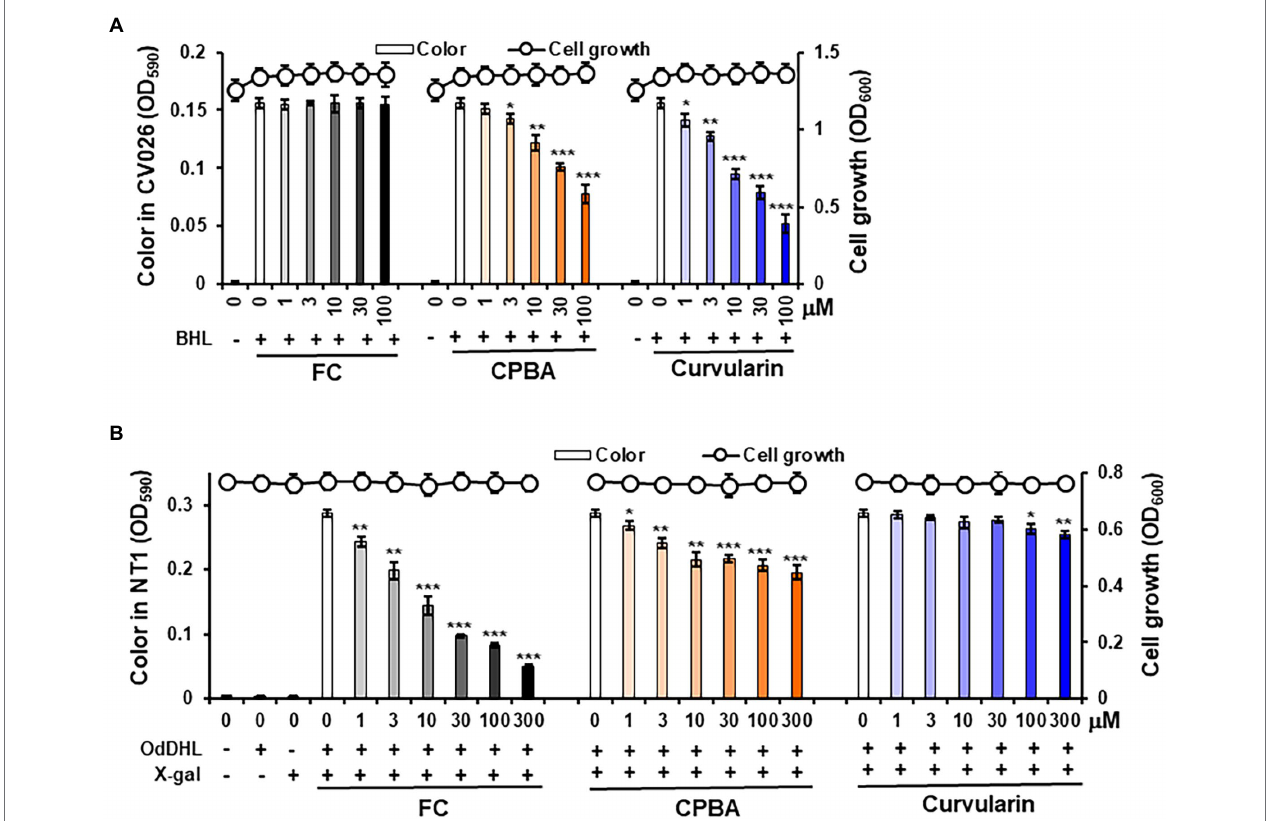
FIGURE 3 | Effects of curvularin on QS. QS competition against N-butanoyl homoserine lactone (BHL) and N-(3-oxododecanoyl)-l-homoserine lactone (OdDHL) was performed using the reporter strains Agrobacterium tumefaciens NT1 and C. violaceum CV026, respectively. After 1 μ M OdDHL and 500 μ M BHL were added to the NT1 and CV026 cultures, respectively, with various concentrations of curvularin and incubated for 24 h, cell growth at 600 nm and color change intensity were measured. (A) Curvularin—BHL competition. (B) Curvularin—OdDHL competition. Furanone C-30 (FC) and N-cyclopentylbutyramide (CPBA) are known antagonists of LasR and RhlR, respectively. The data are expressed as the mean ± SD values of three independent experiments performed in triplicate. *, p < 0.01; **, p < 0.001; and ***, p < 0.0001 versus untreated